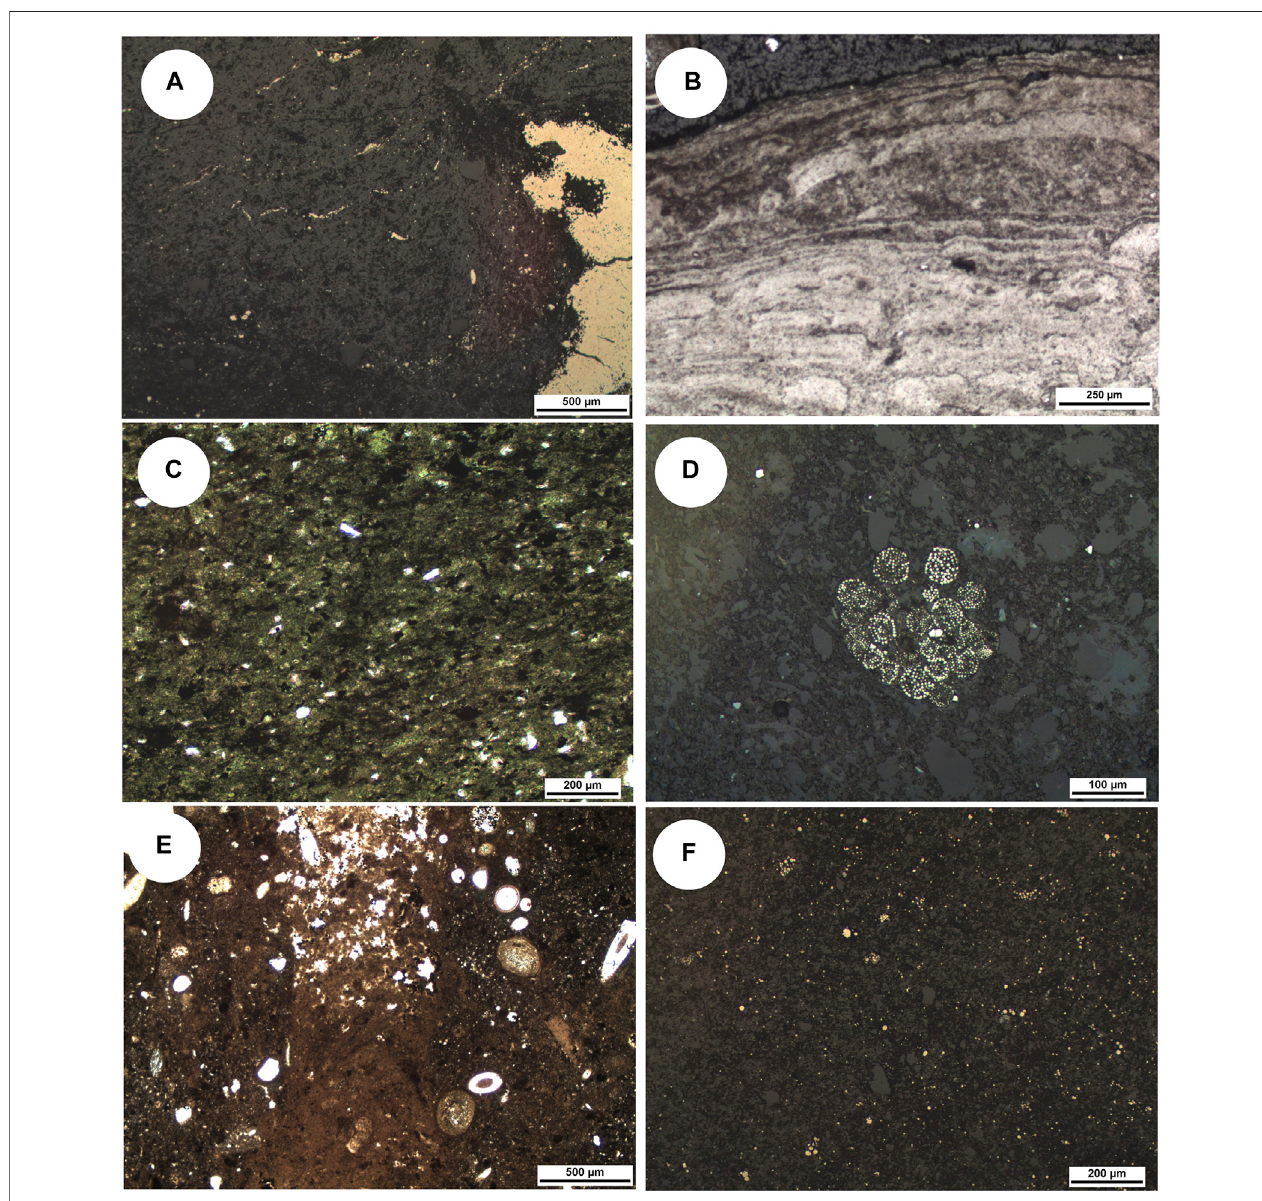
FIGURE 5 | (A) Re fl ected light (RL) photomicrograph of F4 laminated pyritic mudstone displaying rare pyrite nodule to right of frame. Sample HC-18-08 (B) Bacteriogenic precipitate of CFA (photomicrograph in PPL). Sample HC-18-09 (C) Photomicrograph of F5 massive chamosite mudstone with very fi ne quartz silt and organics (PPL). Sample BG-18-34B (D) Framboidal pyrite preserved in F5, only occurs as local clusters 100 – 200 µm diameter (RL photomicrograph). Sample HC-18- 04 (E) Transmitted light photomicrograph of burrow preserved in a phosphate intraclast with passive in fi lling by terrigenous grains in F6. (F) Re fl ected light photomicrograph showing abundant disseminated framboidal pyrite (bright specs) in organic rich F6. Sample